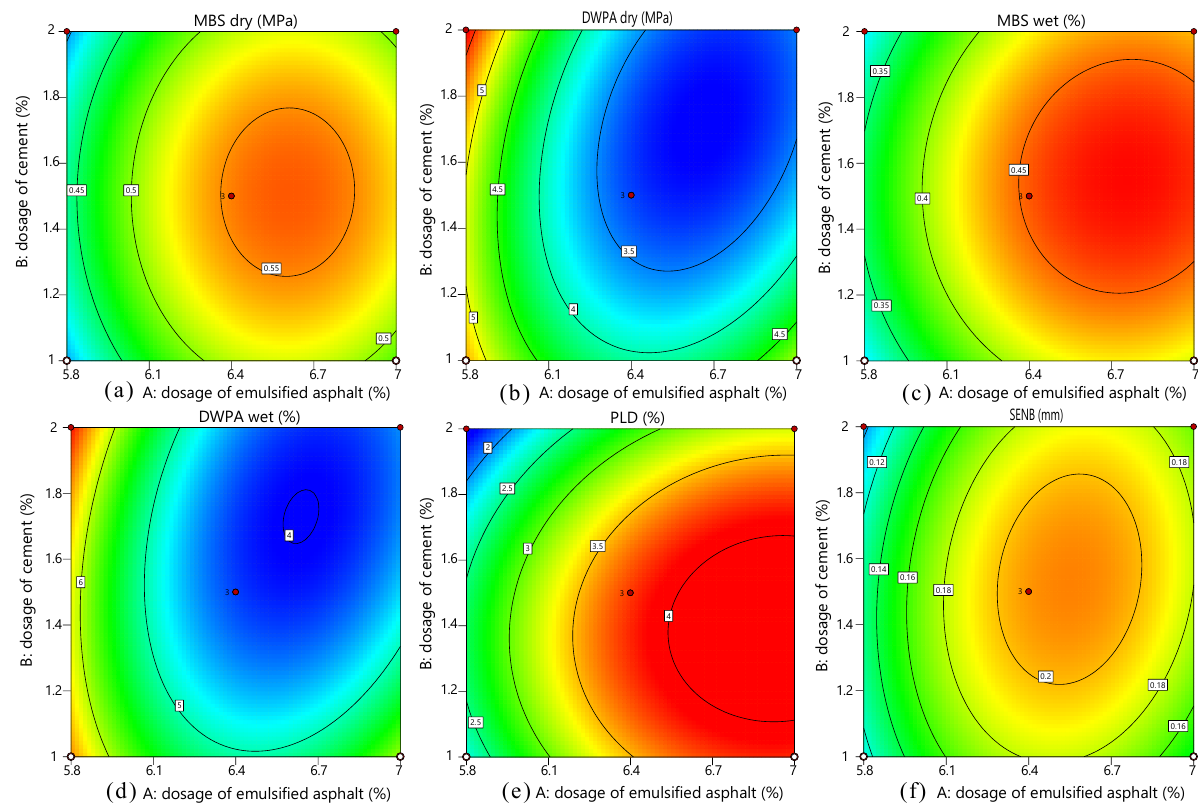
Figure 4. Contour map of the optimized experimental results: ( a ) MBS dry , ( b ) MBS wet , ( c ) DWPA dry , ( d ) DWPA wet , ( e ) PLD, and ( f )